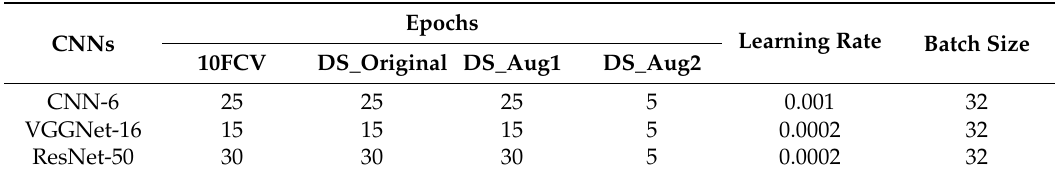
Table 3. Training parameters in ImageCLEF2015 and